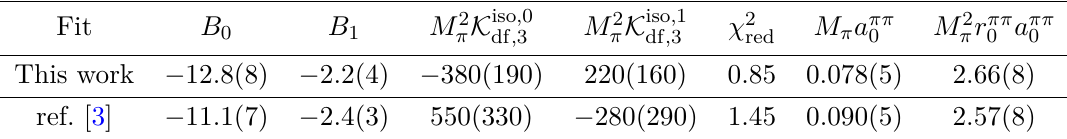
Table 16. Global fits to the two- and three-pion spectrum of D200 including only s -wave interac- tions. We use the 22 energy levels as in ref. [3]: eleven 2 π + levels (all in trivial irreps), and eleven 3 π + levels, including three in nontrivial